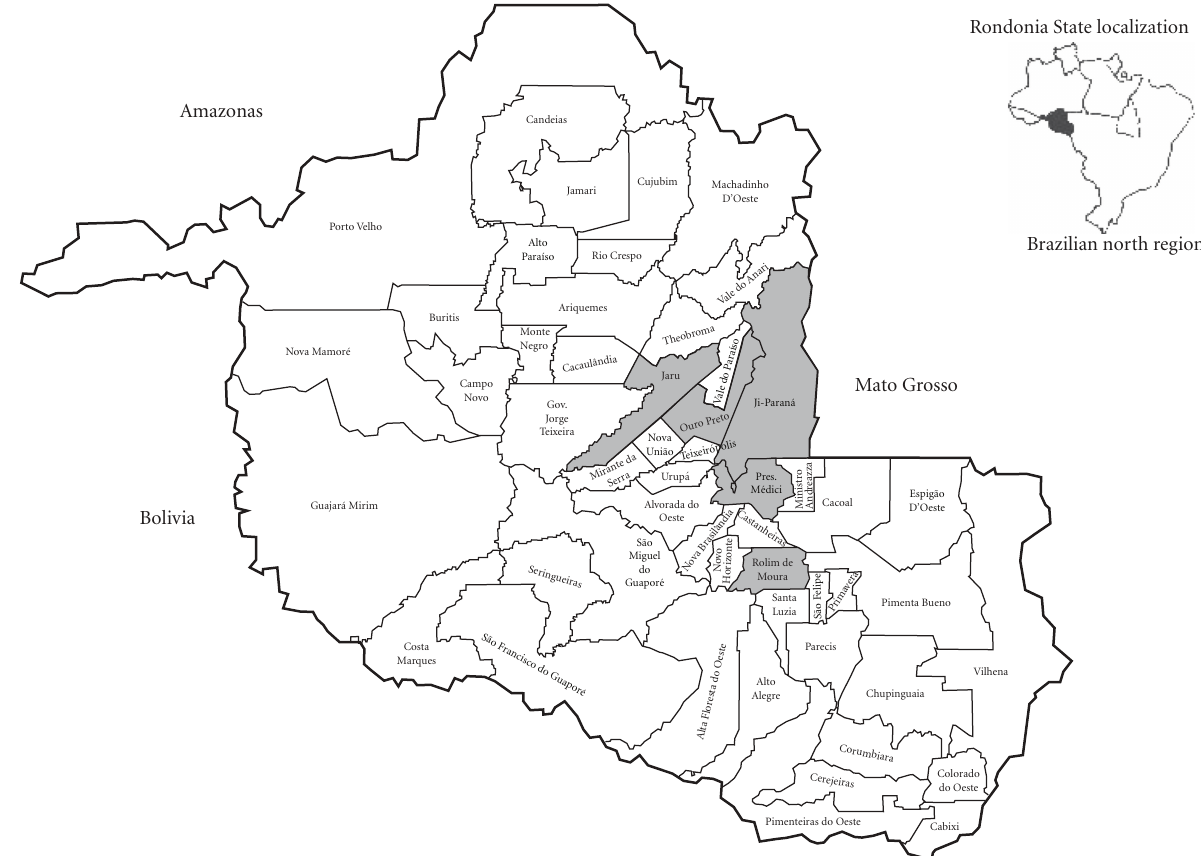
Figure 1: Location of the municipalities in the state of Rondˆonia where the populations of Rhipicephalus microplus were evaluated for e ffi cacy of the